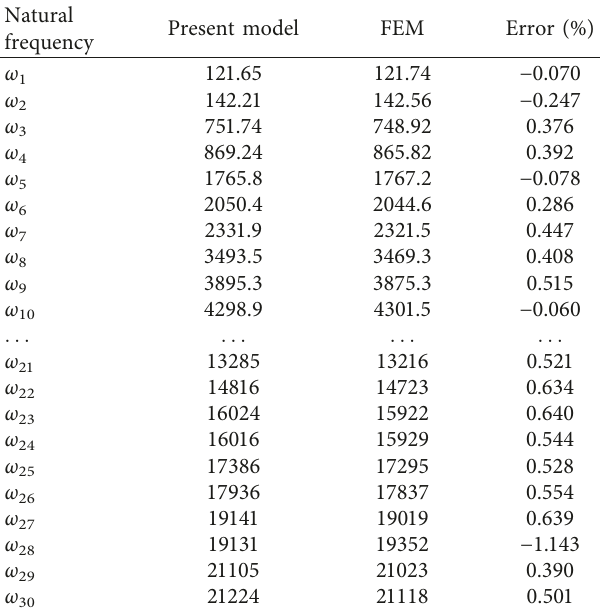
Table 2: Comparison of the first 30 natural frequencies obtained by the present model and FEM. Natural